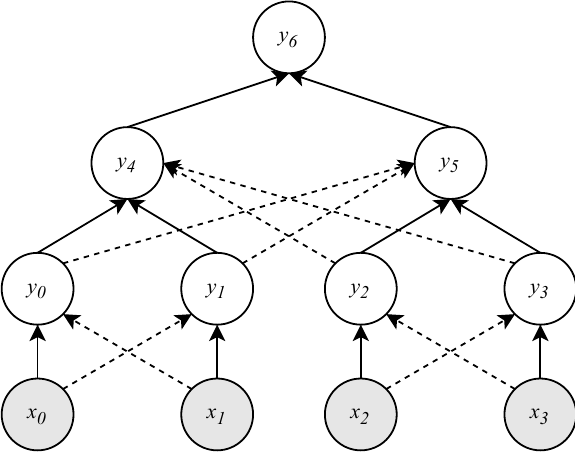
Figure 2. Associate each node with its uncle. The dotted line represents the new association. By taking x 0 as an example, we can get its proof path { y 1 , y 5 } quickly by the new